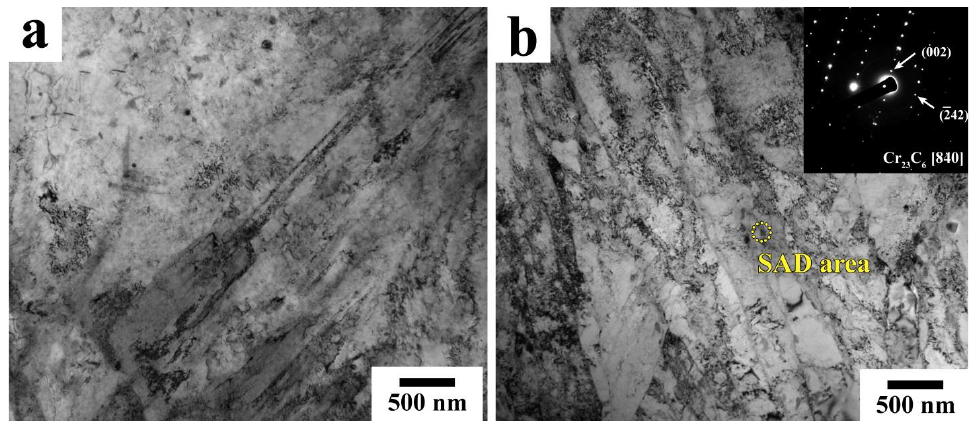
Figure 6. TEM images of lath martensite in the untempered NT ( a ) and HR+Q ( b ) samples.